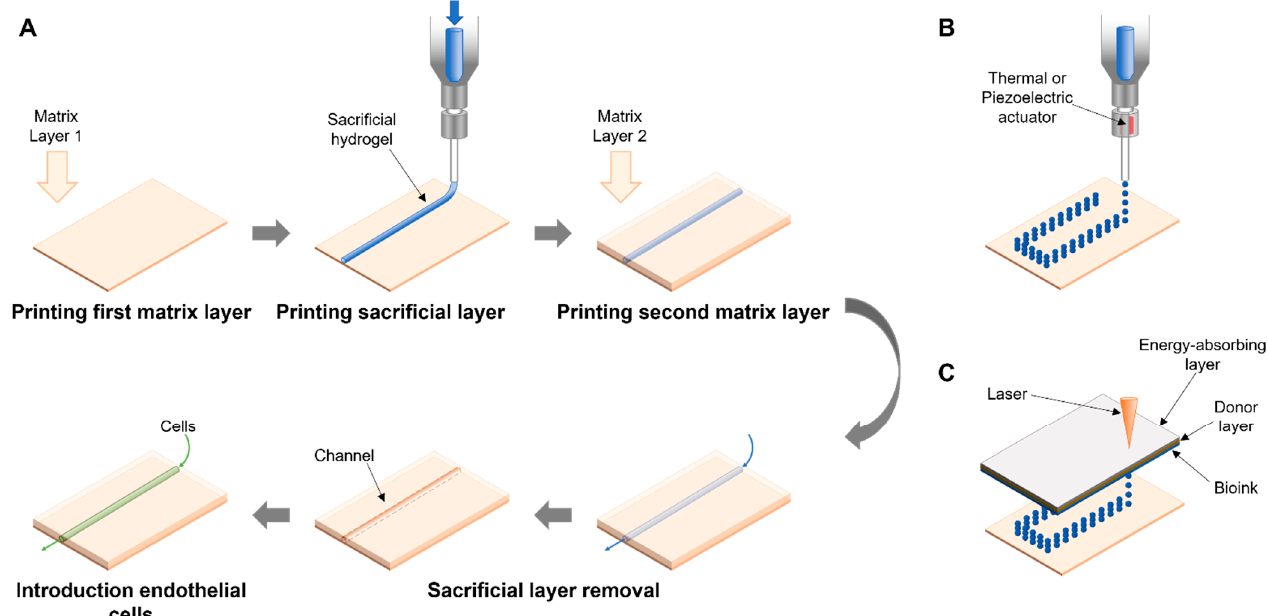
Figure 2. Principle of 3D Bioprinting Scaffold for Vascular Tissue Formation. ( A ) Sacrificial bioprinting. First step in sacrificial bioprinting is to deposit the sacrificial bioink or material onto a first layer of matrix. The sacrificial material (blue) is then covered with a second layer of matrix. Both matrices may be loaded with cells. After polymerization of the hydrogel, the sacrificial material is removed by chemical degradation, photolithography, temperature, or mechanical extraction, generating a hollow channel within the hydrogel block. In the last step, endothelial cells or endothelial progenitor cells are seeded into the hollow channel. ( B ) Droplet-based bioprinting. ( C ) Light- (Laser-)based bioprinting.